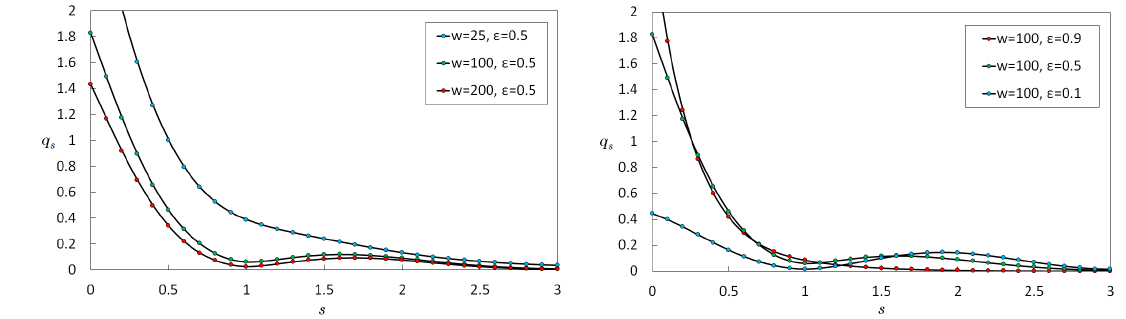
(cid:112) g ( 0 ) D 2 ( 0 ) = 1,